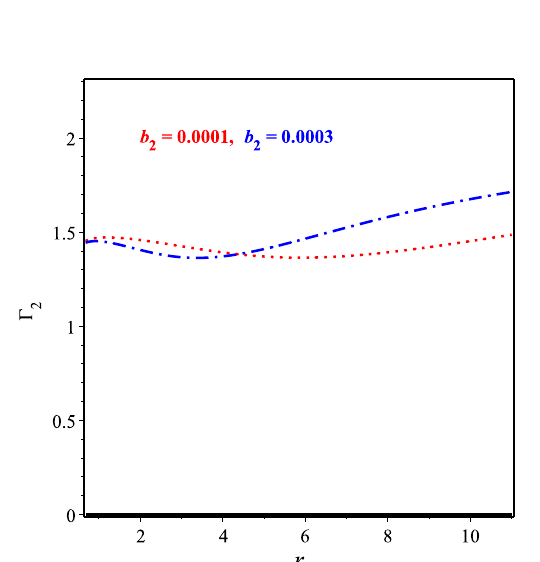
Fig. 8 Adiabatic index of (20) against r in km when b 0 = 0 . 0001, b 1 = 0 . 01 for different values of the b 2 parameter. Note that the larger the value of b 0 , the bigger the amplitude of adiabatic